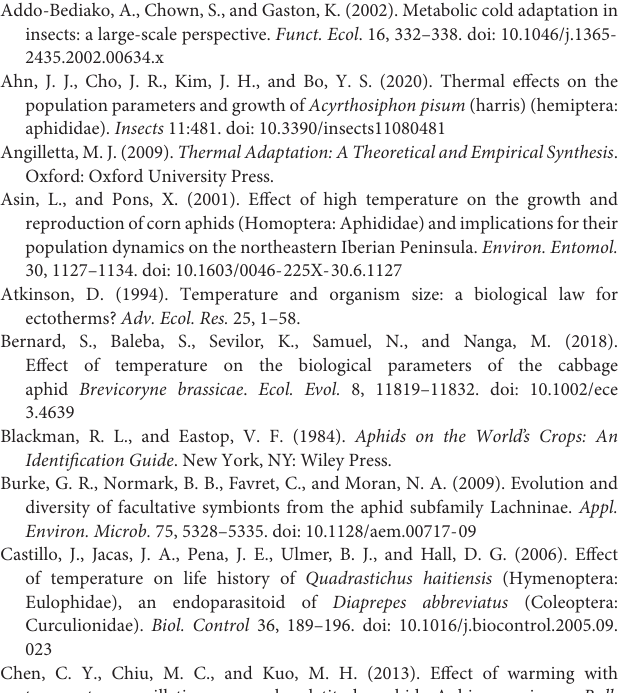
table parameters of predatory thrips Scolothrips longicornis (Thysanoptera: Thripidae) fed on twospotted spider mites (Acari: Tetranychidae). J. Econ. Entomol. 104, 799–805. doi: 10.1603/EC10144 Hales, D. F., Chapman, R. L., Lardner, R. M., Cowen, R., and Turak, E. (2010). Aphids of the genus sitobion occurring on grasses in southern Australia. Austral. Entomol. 29, 19–25. doi: 10.1111/j.1440-6055.1990.tb00308.x Han, Z. L., Tan, X. L., Wang, Y., Xu, Q. X., Zhang, Y., Harwood, J. D., et al. (2019). Effects of simulated climate warming on the population dynamics of Sitobion avenae (Fabricius) and its parasitoids in wheat fields. Pest Manag. Sci . 75, 3252–3259. doi: 10.1002/ps.5447 Hawkes, J. R., and Jones, R. (2005). Incidence and distribution of Barley yellow dwarf virus and Cereal yellow dwarf virus in over-summering grasses in a Mediterranean-type environment. Aust. J. Agric. Res. 56, 257–270. doi: 10.1071/ AR04259 Hochachka, P. W., and Somero, G. N. (2002). Biochemical Adaptation: Mechanism and Process in Physiological Evolution . Oxford: Oxford University Press. Huang, X., Liu, D., Wang, D., Shi, X., and Simon, J. C. (2015). Molecular and quantitative genetic differentiation in Sitobion avenae populations from both sides of the Qinling Mountains. PLoS One . 10:e0122343. doi: 10.1371/journal. pone.0122343 Huang, Y. B., and Chi, H. (2012). Age-stage, two-sex life tables of Bactrocera cucurbitae (Coquillett) (Diptera: Tephritidae) with a discussion on the problem of applying female age-specific life tables to insect populations. Insect Sci. 19, 263–273. doi: 10.1111/j.1744-7917.2011.01424.x Huey, B., and Kingsolver, J. G. (1993). Evolution of Resisitance to High Tempera in Ectotherms . Chicago: University of Chicago Press. Huey, R. B., and Kingsolver, J. G. (1989). Evolution of thermal sensitivity of ectotherm performance. Trends Ecol. Evol. 4, 131–135. doi: 10.1016/0169-